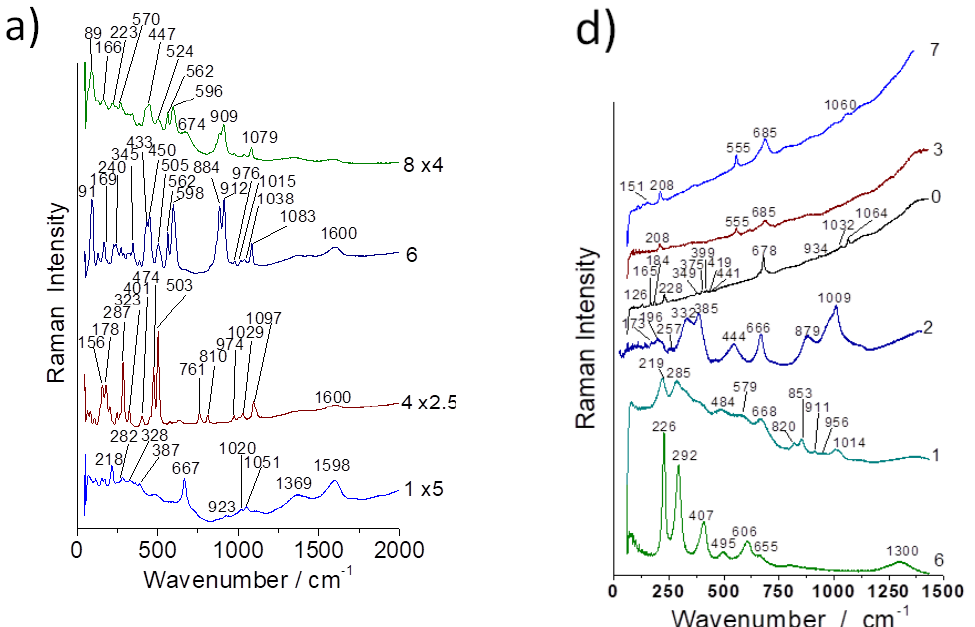
Figure 8. Representative Raman spectra recorded on some spots of samples a ( left ) and d ( right ) (see Figure 1).